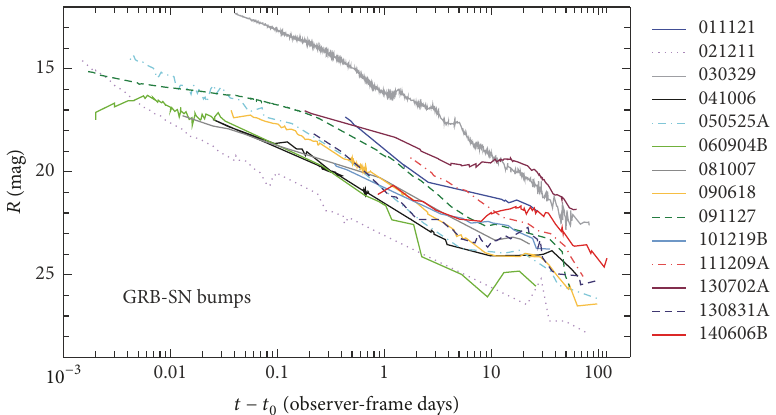
Figure 3: A mosaic of GRB-SNe (AG + SN). Clear SN bumps are observed for all events except SN 2003dh, for which the SN’s properties had to be carefully decomposed from photometric and spectroscopic observations [7]. The lack of an unambiguous SN bump in this case is not surprising given the brightness of its AG relative to the other GRB-SN in the plot: SN 2013dx was at a comparable redshift ( 𝑧 = 0.145 , compared with 𝑧 = 0.1685 for 2003dh), but its AG was much fainter (2–5 mag) at a given moment in time. The redshift range probed in this mosaic spans almost an order of magnitude ( 0.145 < 𝑧 < 1.006 ) and shows the variation in peak observed magnitude for GRB-SNe. It is important to remember that given the large span of distances probed here, observer-frame 𝑅 -band samples a wide range of rest-frame SEDs (from 𝑈 -band to 𝑉 -band).